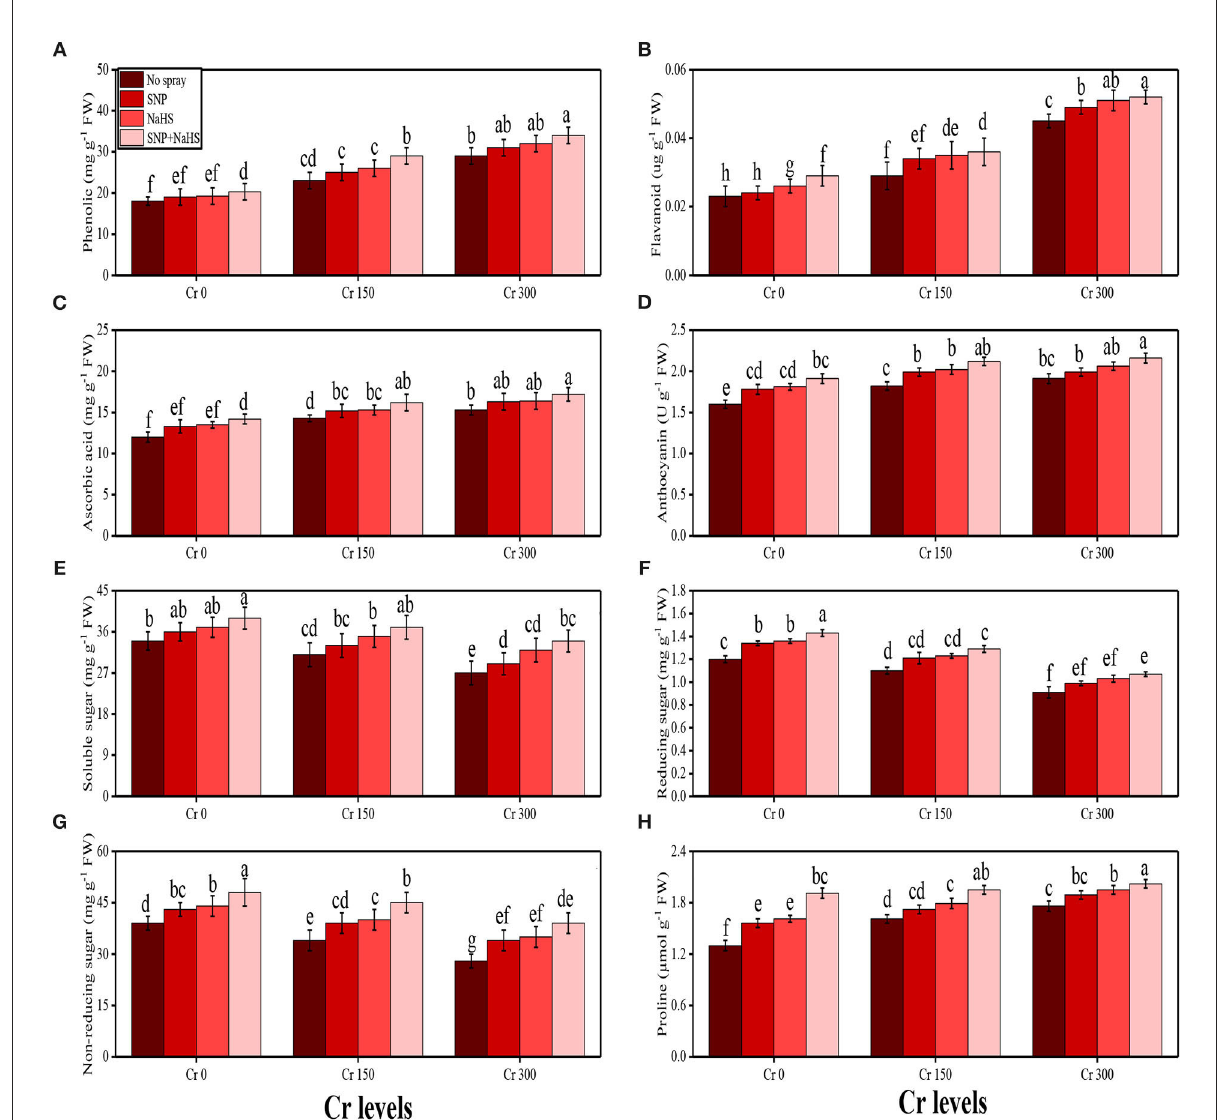
FIGURE4 Impact of individual and combinatorial application of SNP and NaHS on osmolytes and sugars, i.e., phenolic content (A) , flavonoid content (B) , ascorbic acid content (C) , anthocyanin content (D) , soluble sugar content (E) , reducing sugar content (F) , non-reducing sugar content (G) , and proline content (H) of spinach ( S. oleracea ) plants grown under different levels of Cr [0 (no Cr), 150, and 300 µ M] in sandy loam soil. Values in the figures indicate just one harvest. Mean ± SD ( n = 4). Two-way ANOVA was performed and mean differences were tested by HSD ( P < 0.05). Different lowercase letters on the error bars indicate significant differences between the